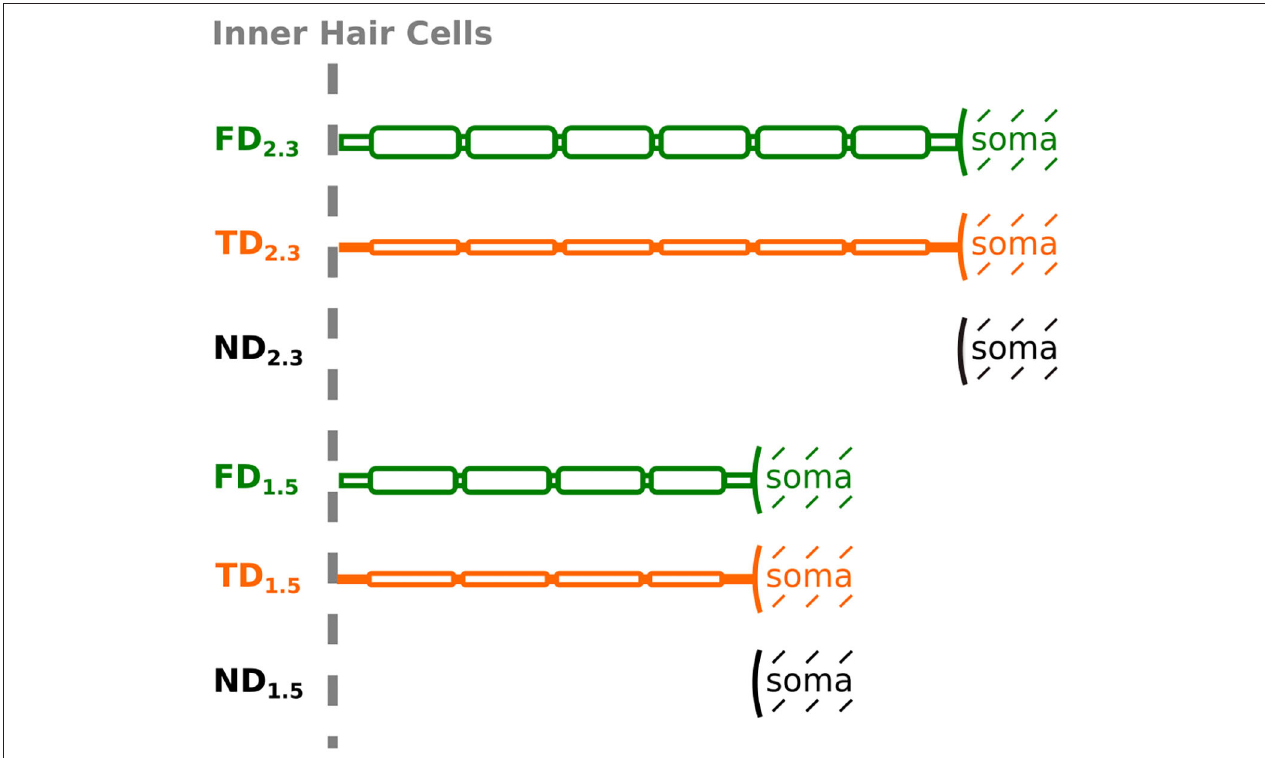
FIGURE 4 | Schematic representation of an ANF for different degenerative states and dendrite lengths, depicted up to soma (not to scale). Degenerative state is indicated by name [FD, Full (intact) Dendrite; TD, Thin Dendrite; ND, No Dendrite] and dendrite length is indicated by the